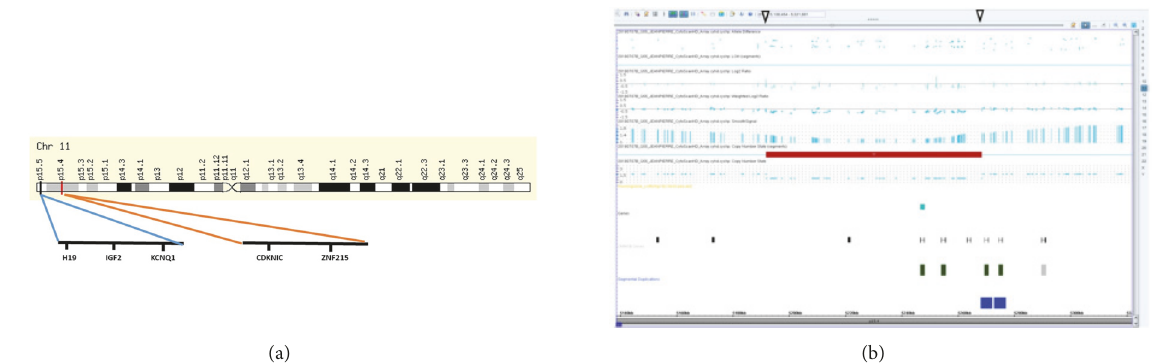
Figure 8: (a) Ideogram of chromosome 11 and deleted region (red bar) and genes involved with BWS. (b) Microarray showed 11p15.4 deletion